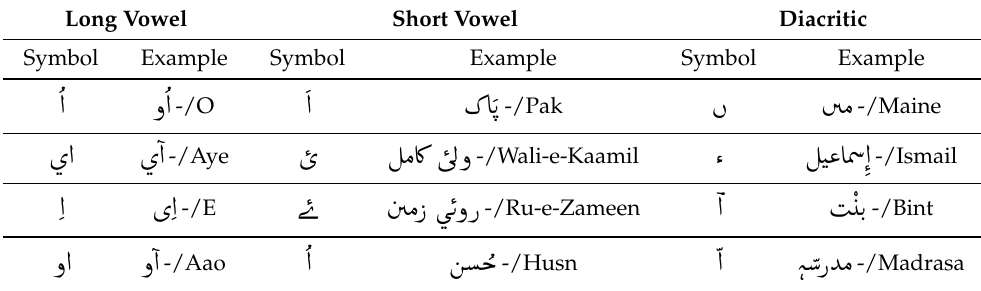
Table 2. Examples of long vowels, short vowels, and diacritics in Urdu Morphology. Long Vowel Short Vowel